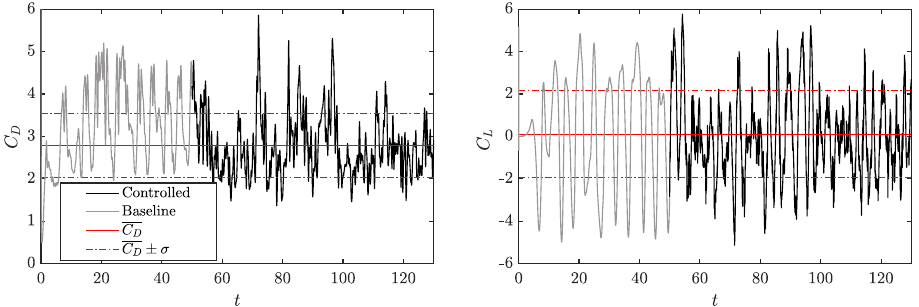
Figure 13. Temporal evolution of C D ( left ) and C L ( right ) obtained through the application of the DRL control (at t = 50), run in a deterministic mode, for Re =